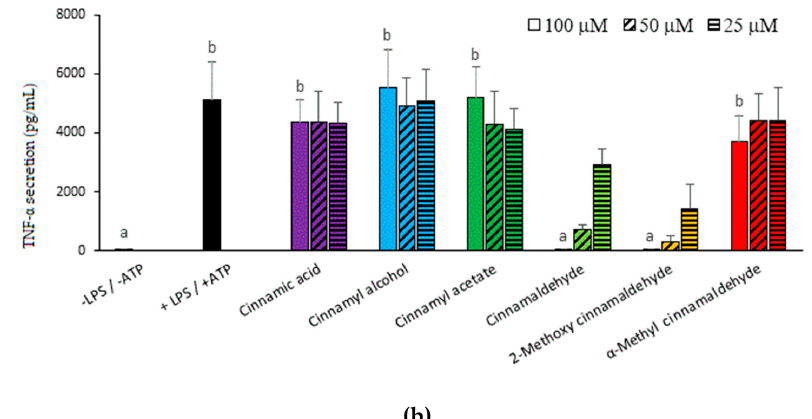
Figure 2. Influence of cinnamaldehyde-related compounds on canonical interleukin (IL)-1 β ( a ) and TNF- α secretion ( b ). The macrophages were pretreated with 100 μ M cinnamaldehyde-related compounds for 30 min and then treated with lipopolysaccharide (LPS) and adenosine 5 ′ -triphosphate (ATP). Data are expressed as the mean ± SD and different superscript letters among 100 μ M treatment groups represent statistically significant differences ( p < 0.05).